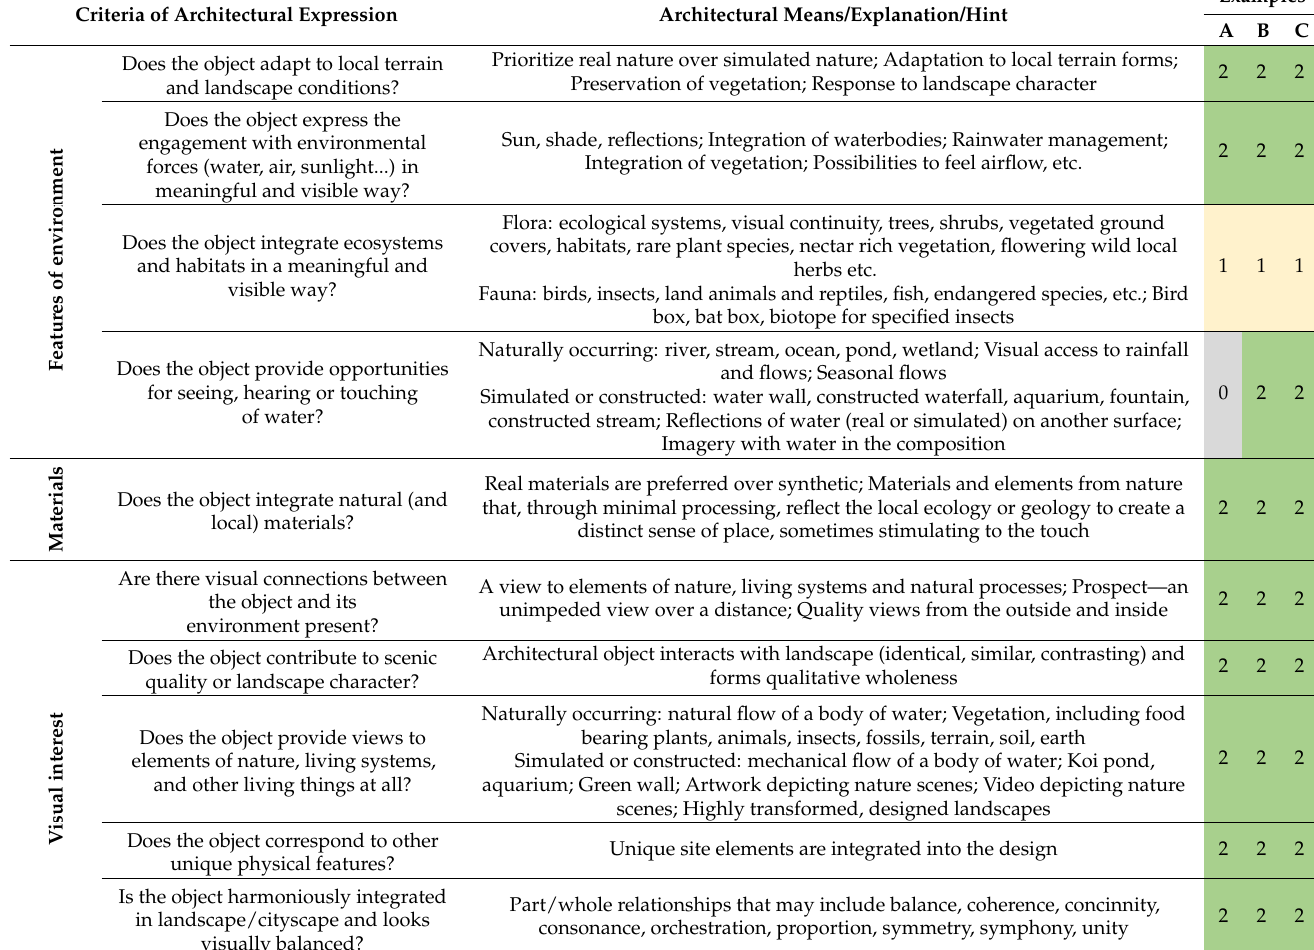
Table 1. Questions used for the assessment of selected buildings as a means for design evaluation from sustainability aesthetics, biophilic design, and human–nature collaboration points of view [1,5,7,20–26]. Buildings correspondence to the criterion is evaluated in the scale from 0 to 2: None = 0 (gray color in the table); Some = 1 (yellow color in table); Clearly expressed = 2 (green color in the table). Examples Architectural Means/Explanation/Hint A B